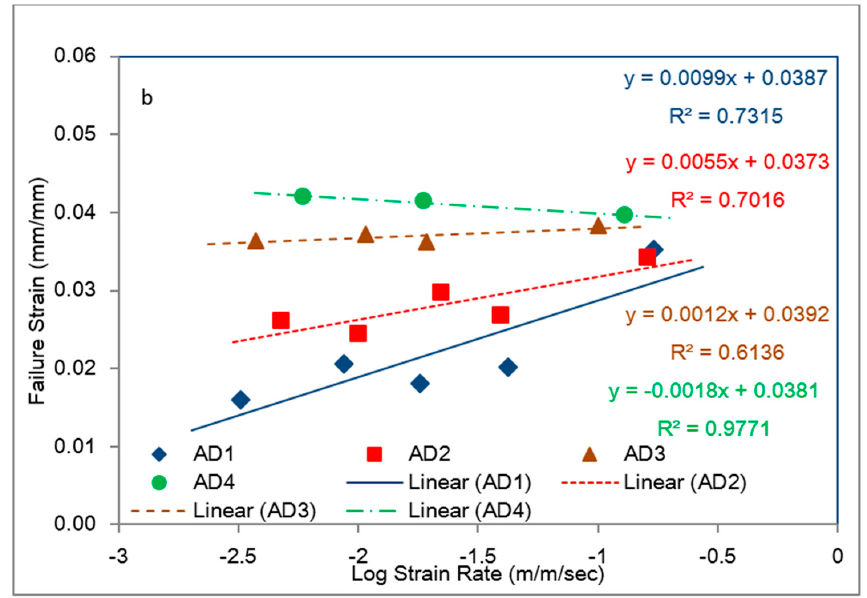
Figure 22. Variation of the failure strain as a function of strain rate during tensile tests.